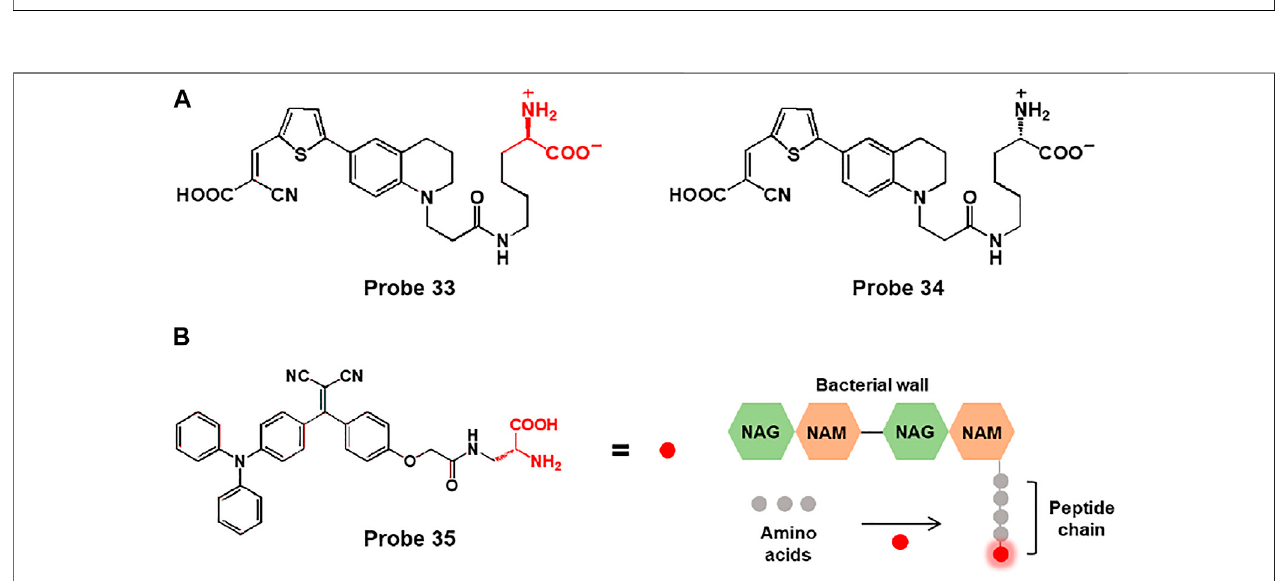
FIGURE 17 | (A) Chemical structures of probes 33 and 34. (B) Chemical structure of probe 35 and the schematic of the bacterial wall labelling with the D-Ala moiety.